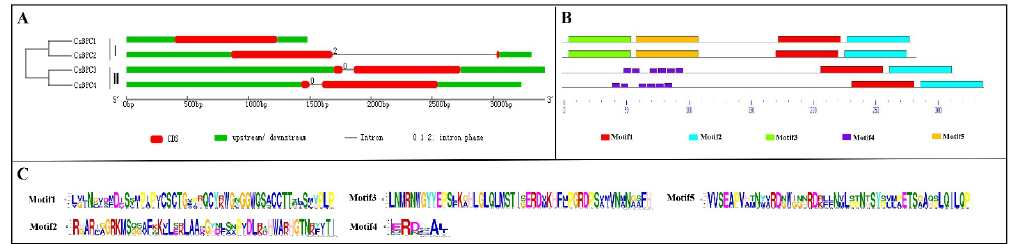
Figure 3. Gene structure and conserved motif analyses of cucumber BPC members. ( A ) Exon–intron organization of CsBPC genes. Red boxes represent exons and the black lines represent introns. The numbers 0, 1, and 2 represent the intron phases. The untranslated 5′- and 3′- regions (UTR) are shown with green boxes. ( B ) Conserved motif in cucumber BPC proteins. Five motifs with E-value < 0.05 are presented with different colored boxes. ( C ) The sequences of five identified motifs in cucumber BPC proteins.